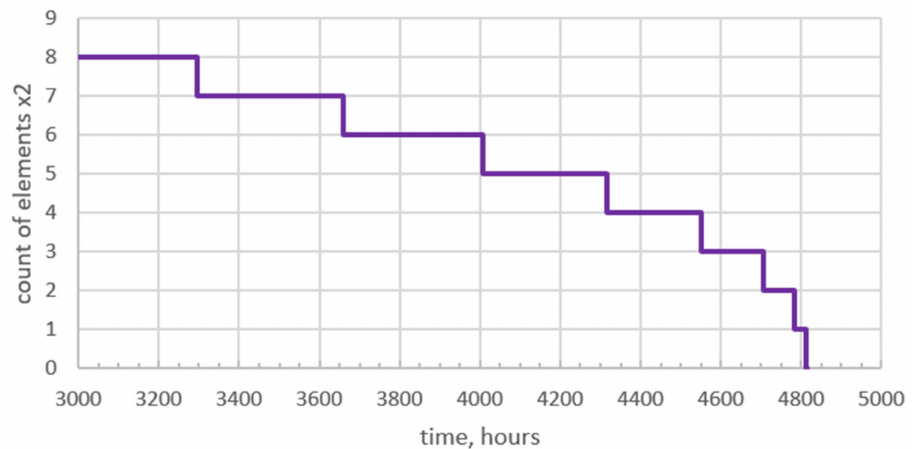
Figure 8. A fragment of a histogram of the hierarchical ramified system’s operation in the course of ( 1 ) = 5, a ( 2 ) = 15. time for a 2 2